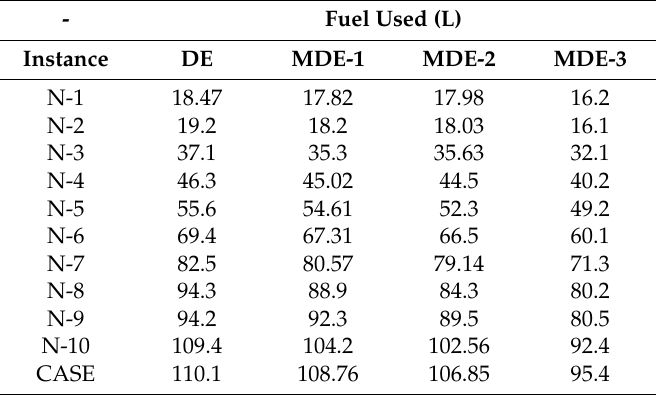
Table 16. The results of the proposed heuristics.